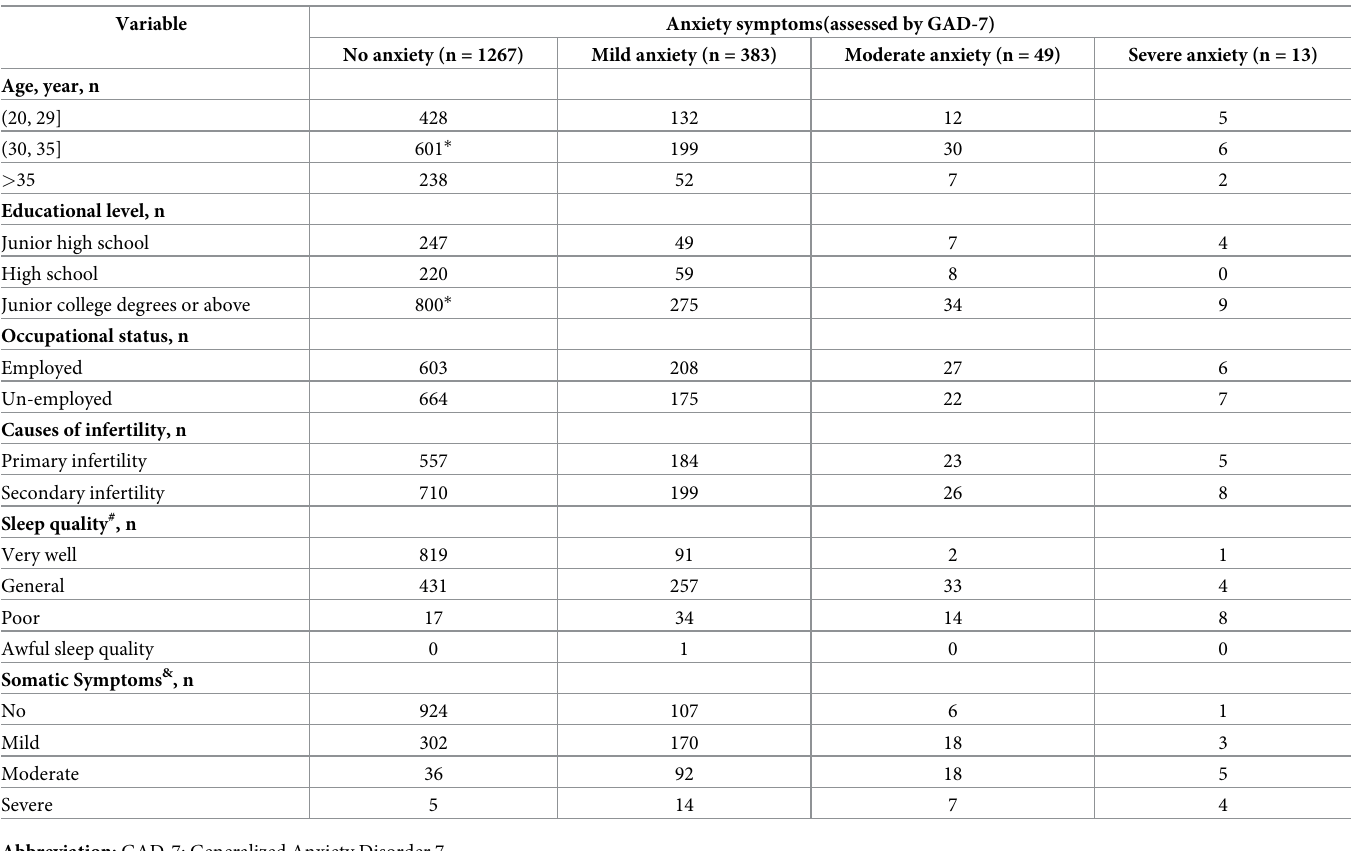
Table 1. The baseline characteristics of infertility women in this